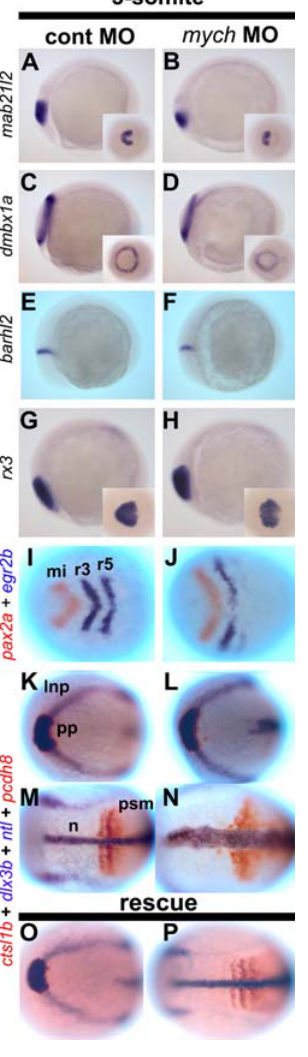
Figure 4. Mych MO affects multiple regions at the 3-somite stage. A–P. Lateral views (A–H) and dorsal views (I–P) of control MO- injected (A,C,E,G,I,K,M) and mych MO-injected embryos (B,D,F,H,J,L,N). Mab21l2 (A–B’) as eye anlage and midbrain marker; dmbx1a (C–D’) as eye territory and tectum marker; barhl2 (E,F) as diencephalon marker; rx3 as eye field marker. (I–J) double label with pax2a (red) and egr2b (blue). (K–P). Embryos were examined using four probes, ctsl1b (red), dlx3b (blue), ntl (blue), and pcdh8 (red). (O–P) mych MO-induced defects were rescued by co-injection with mych mRNA. lnp, lateral neural plate; mi, midbrain; n, notochord; pp, prechordal plate; r, rhombomere; psm, pre somitic mesoderm.